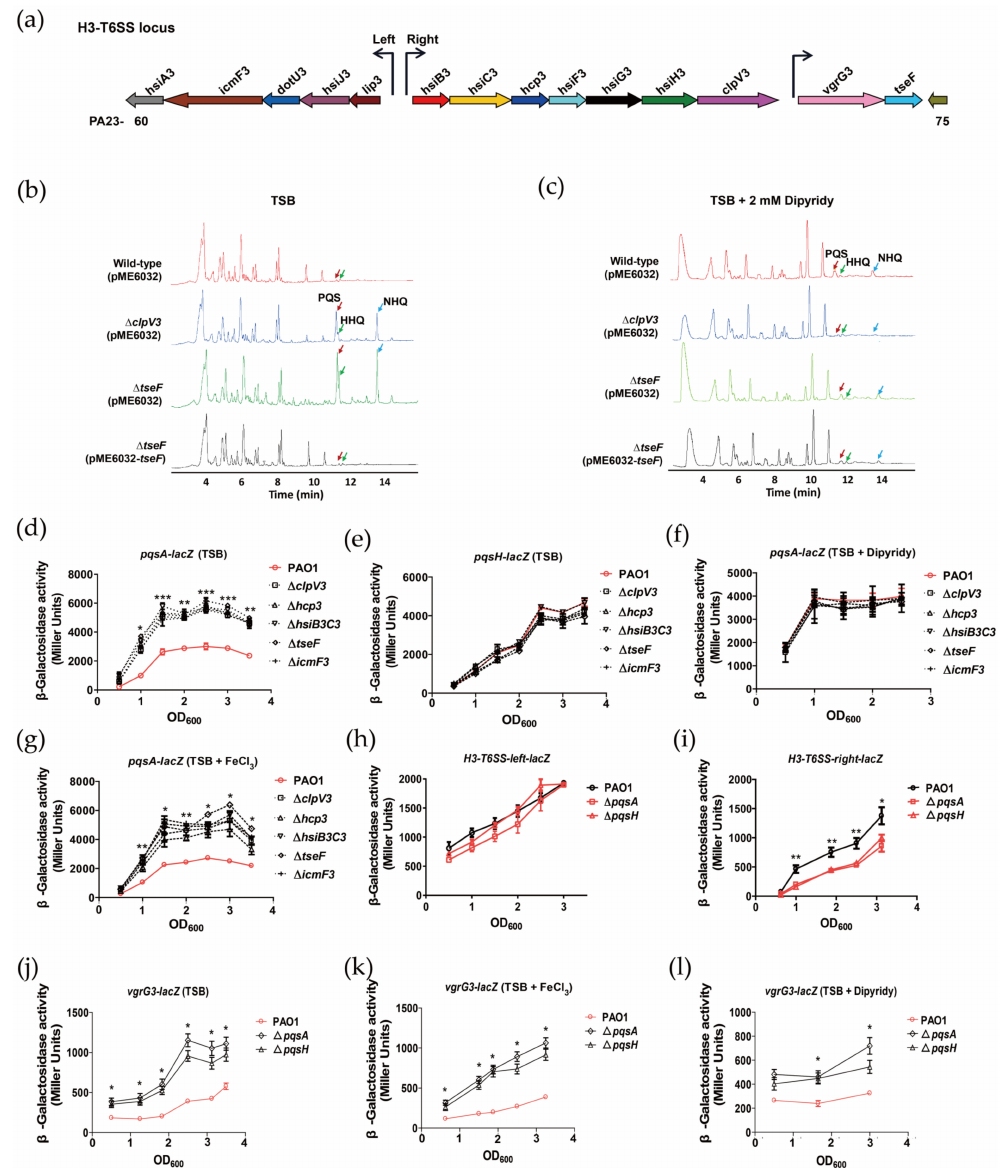
Figure 1. H3-T6SS inhibits the synthesis of PQS, while PQS differentially regulates the expression of the H3-T6SS structural gene and tseF . ( a ) H3-T6SS is organized in three putative operons. The genes are labeled hsiA3 to hsiJ3 for the left operon, hsiB3 to hsiH3 for the right operon, and vgrG3 and tseF for the vgrG3-tseF operon. The gene annotation numbers are also indicated (e.g., PA2360). The promoter region of each operon is also shown. ( b , c ) LC-MS analysis of cell cultures of relevant P. aeruginosa strains. The samples were extracted from the cell culture grown in a TSB medium or in TSB with 2 mM dipyridyl. The mass spectra of PQS, HHQ, and NHQ are shown in Figure S1. ( d – g ) Levels of pqsA and pqsH transcription in P. aeruginosa wild-type strain. The H3-T6SS mutants were monitored using pqsA–lacZ and pqsH-lacZ transcriptional fusion. The experiments were performed in TSB, TSB with 2 mM dipyridyl, and TSB with 200 µ M FeCl 3 . ( h , i ) Expression patterns of the H3-T6SS left and H3-T6SS right lacZ transcriptional fusions for the wild-type strain, ∆ pqsA , and ∆ pqsH . The expression is given in Miller units at different OD 600 during growth at 37 ◦ C in TSB medium. ( j – l ) Levels of vgrG3-tseF transcription in P. aeruginosa WT and PQS-deficient mutants were monitored using the vgrG3–lacZ transcriptional fusion. The experiments were performed in TSB, TSB with 200 µ M FeCl 3 , and TSB with 2 mM dipyridyl. The graph shows the mean and SD of three experiments performed in five replicates each time. * denotes p < 0.05, ** denotes p < 0.01, and *** denotes p < 0.001 (compared to